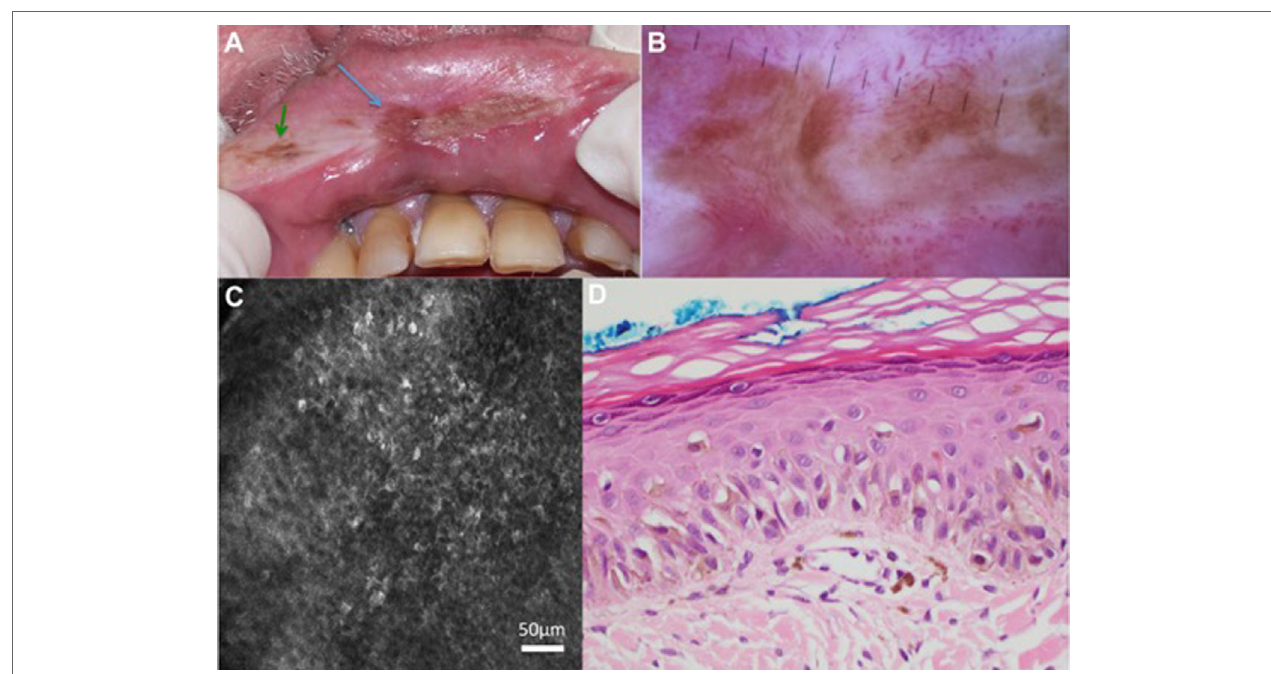
FigURe 4 | Patient with previously treated lentigo maligna (LM) melanoma had a new brown pigmented areas (indicated with the arrows) on clinical examination (a) and dermoscopy (B) . Reflectance confocal microscopy (RCM) of the pigmented area in the middle of the upper lip (blue arrow) showed round cells with dendritic processes in the epidermis (C) . RCM-targeted biopsy of this was performed and histopathology confirmed recurrence of LM (D) . Not shown in this figure: the pigmented area indicated by the green arrow showed features in keeping with solar lentigo on RCM. Permissions obtained to reprint from Maher et al.